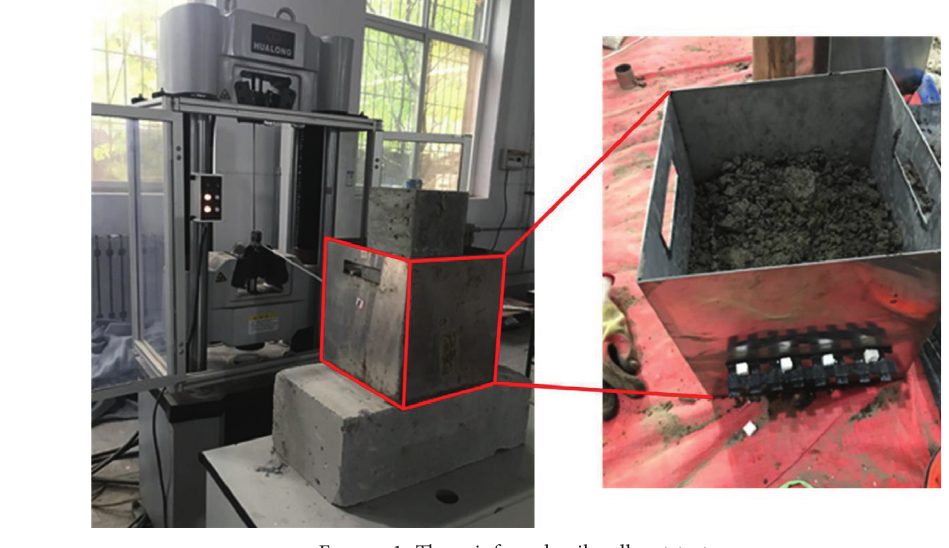
Figure 1: The reinforced soil pull-out test. Table 1: Filler physical and mechanical parameters.